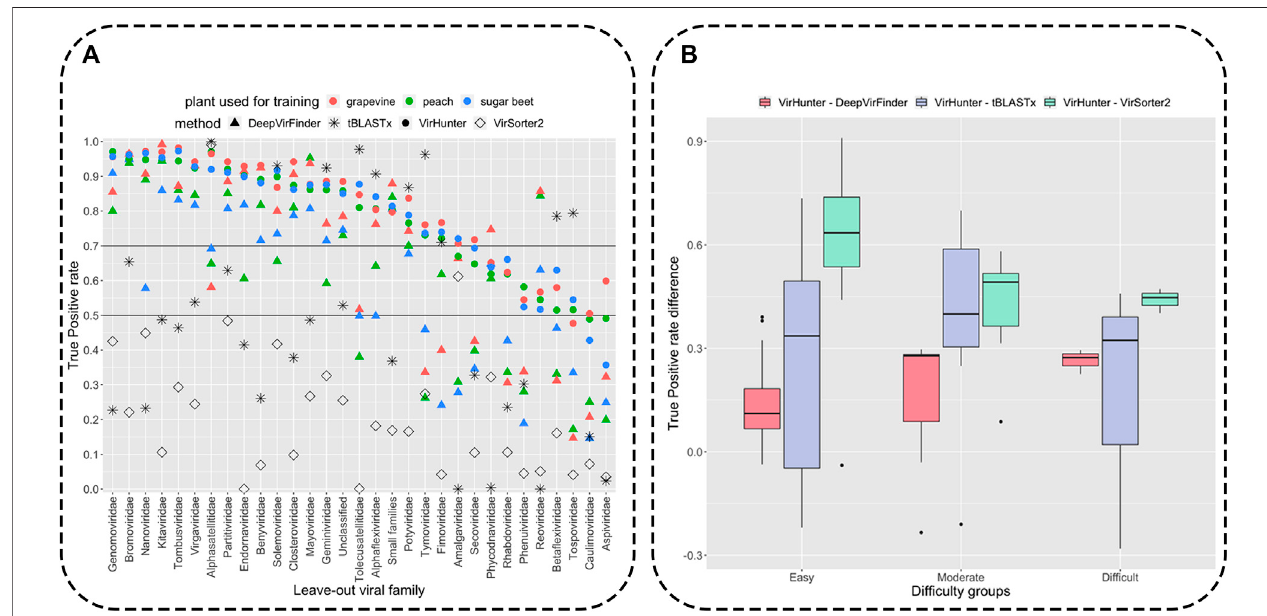
FIGURE 3 | Detection of novel viral fragments in the family leave-out setup. Panel (A) : Results for the percent of correctly classi fi ed fragments (out of 10 , 000) with length n (cid:2) 1000 from the corresponding left-aside families. VirHunter results are depicted by circles, tBLASTx by stars, DeepVirFinder by triangles, and VirSorter2 by diamonds. Black lines represent thresholds separating families into three dif fi culty groups for VirHunter as follows: easy to classify (minimum TP rate across the three plants > 0 . 7), dif fi cult to classify (minimum TP rate < 0 . 5), and moderately dif fi cult to classify (minimum TP rate between 0 . 5 and 0 . 7). Panel (B) : Differences in the True Positive rate between VirHunter, DeepVirFinder (red), tBLASTx (blue), and VirSorter2